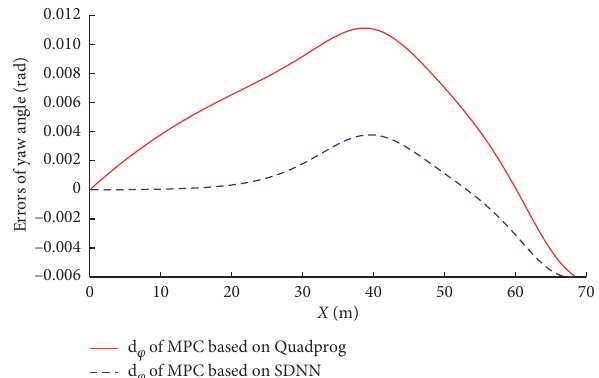
Figure 27: Errors of yaw angle of two controllers.